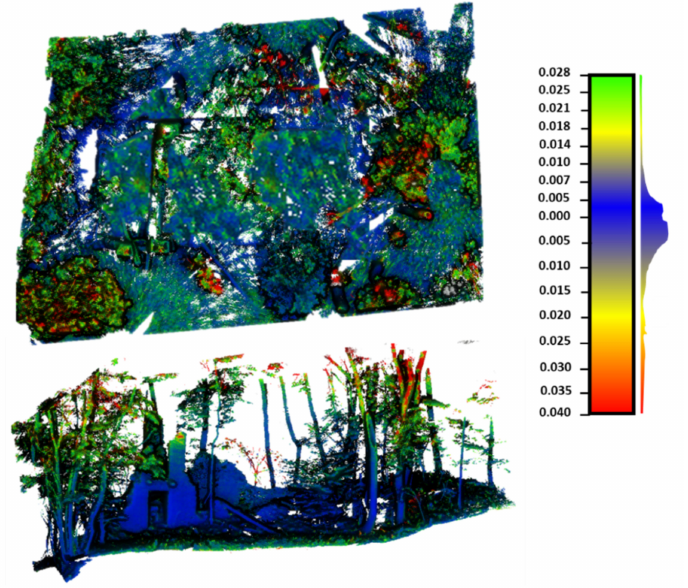
Figure 14. Discrepancies obtained from the comparison of the TLS and MMS point clouds. It is observed that most of the MMS point clouds show a blue color, indicating that the discrepancies between the MMSS and the TLS are under or near 1 cm. Yellow, red, and blue areas indicate vegetation zones (with minimal wind, they can move and generate discrepancies between point clouds).